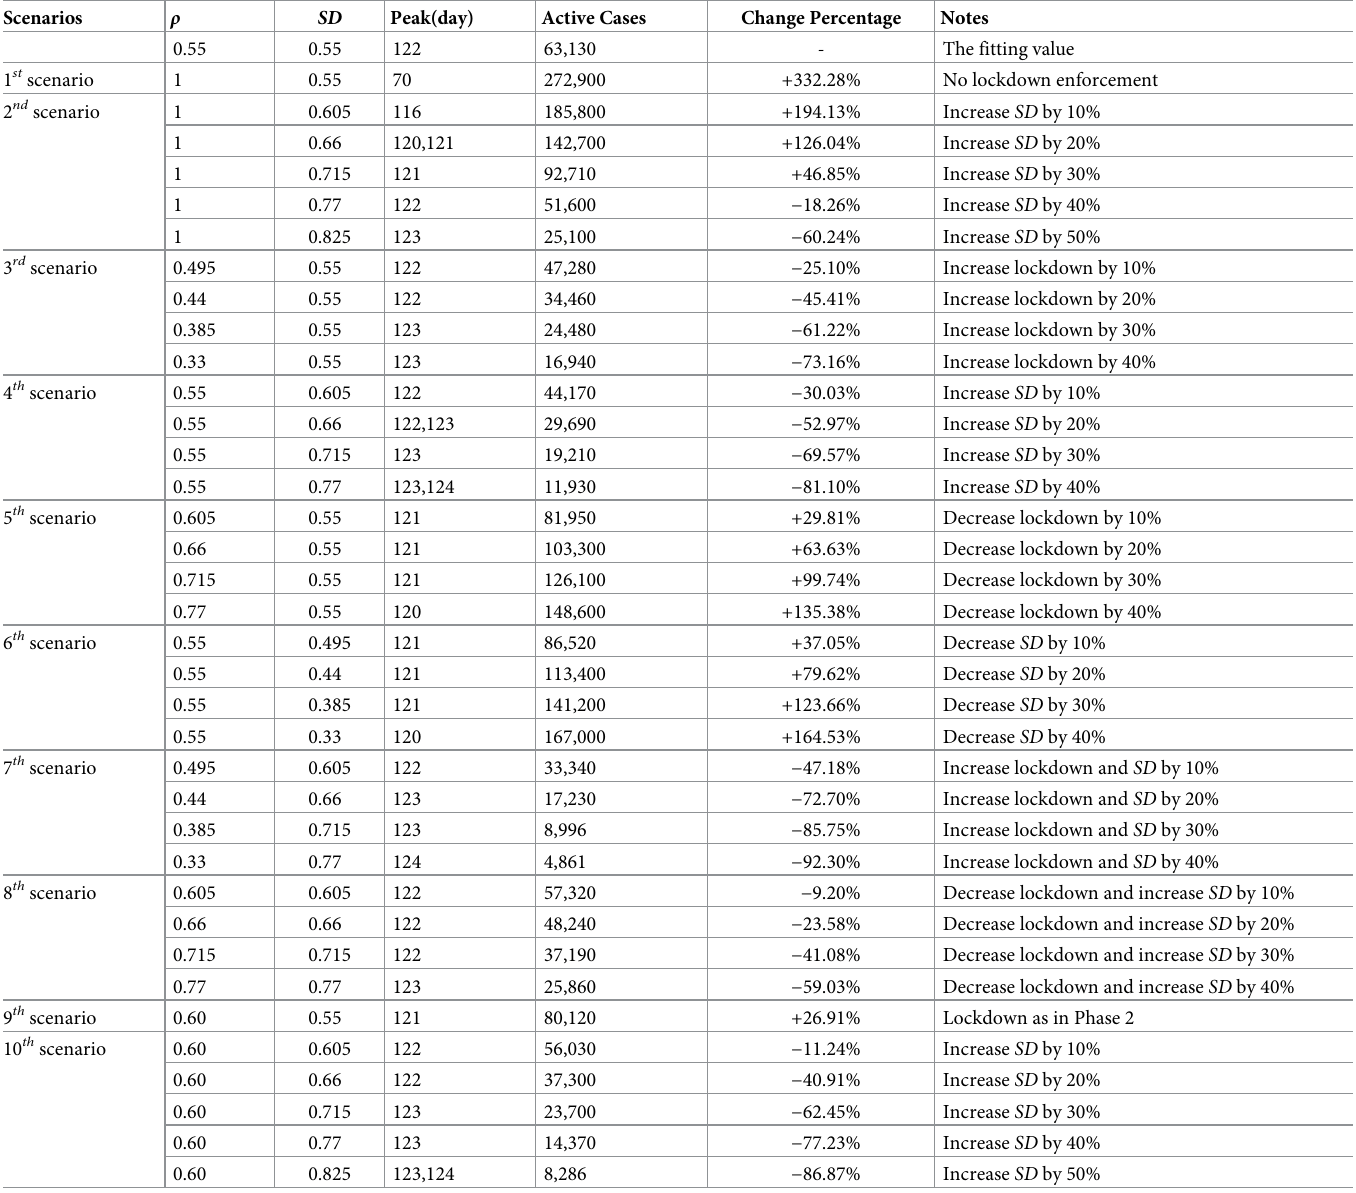
Table 7. Results of different scenarios for Phase